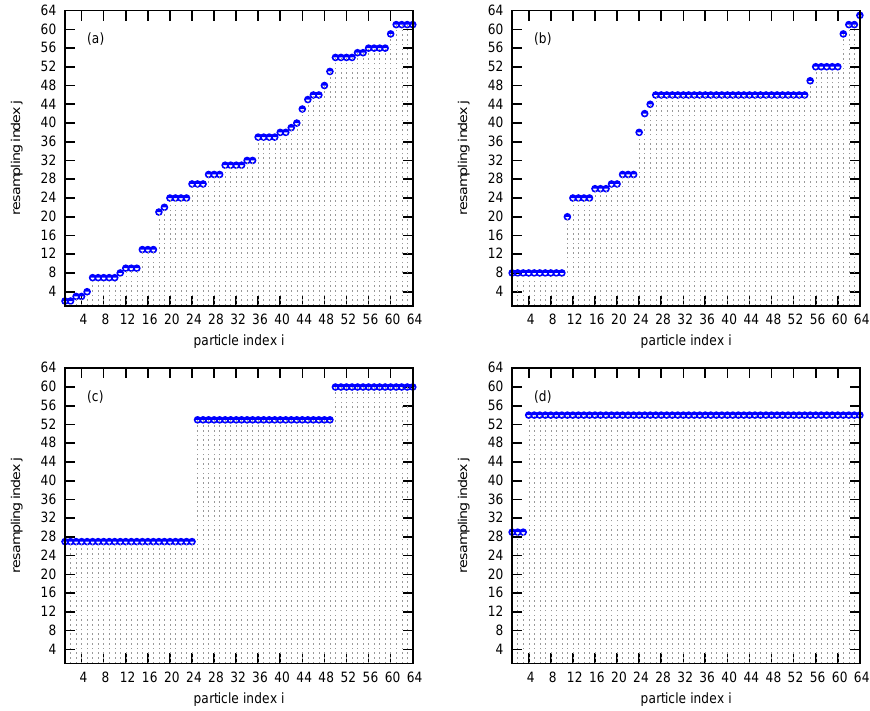
Fig. 3. Extreme particle replication example with N = 64: (a) and (b) present a proper resampling performance whereas (c) and (d) show the extreme replication problem. The sample set collapses to particles located at 27th, 53th and 60th positions in (c) and almost all the set collapses to the value of the particle at the 54th position in (d)